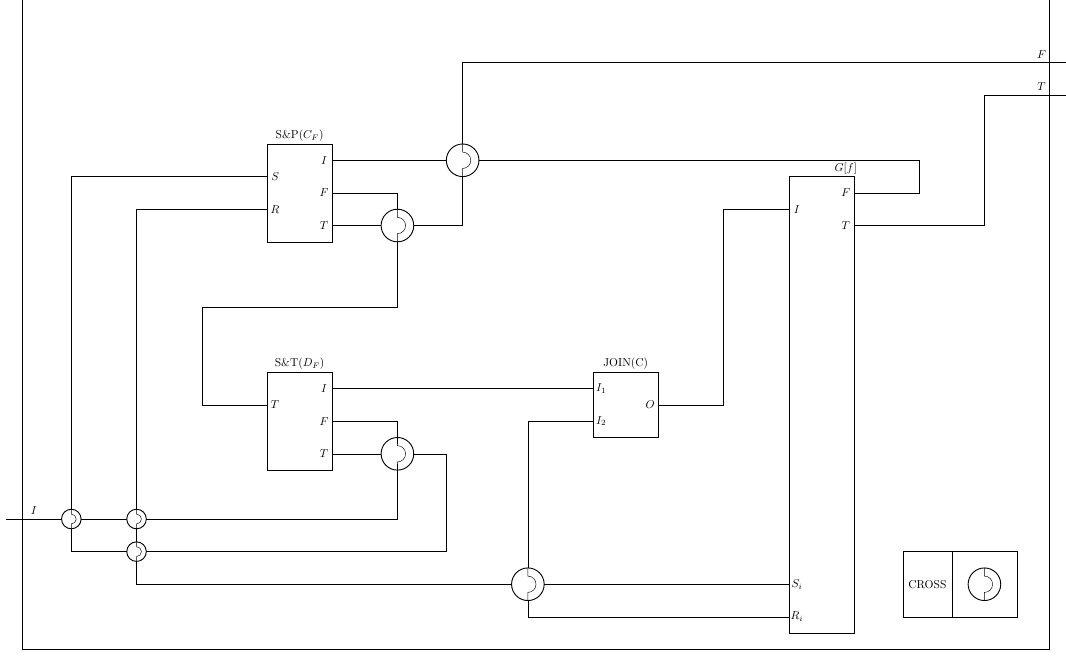
Figure 23. G [( ∃ x ) f ]